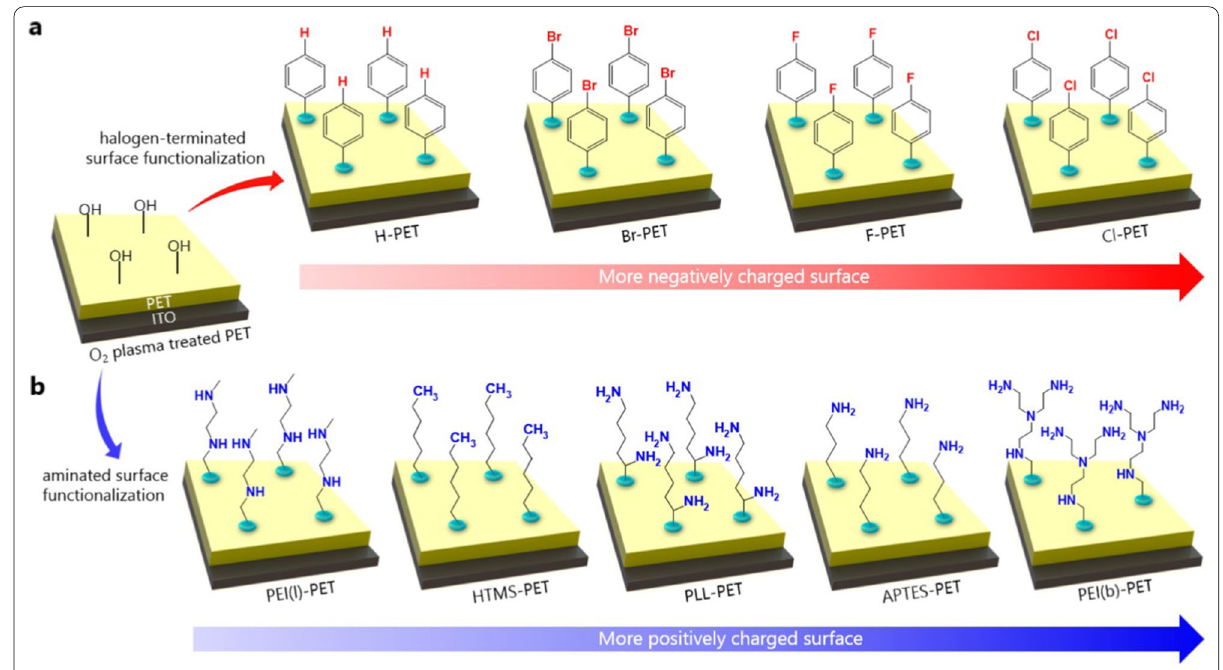
Fig. 10 Schematic representations of surface functionalized negative and positive PETs with adopted molecules. The PET/ITO substrates were treated by O 2 plasma to form hydroxyl (–OH) groups on the PET surface for strong hydrogen bonding with target molecules. a PET surfaces were functionalized with halogen (Br, F, and Cl)-terminated phenyl derivatives for negatively charged surfaces. b Aminated molecules, such as linear polyethyleneimine (PEI(l)), hexyltrimethoxysilane (HTMS), poly-L-lysine (PLL), 3-aminopropyltrimethoxysilane (APTES), and branched polyethylenimine (PEI(b)), were functionalized on the O 2 plasma treated PET surfaces (Reproduced with permission from Ref.